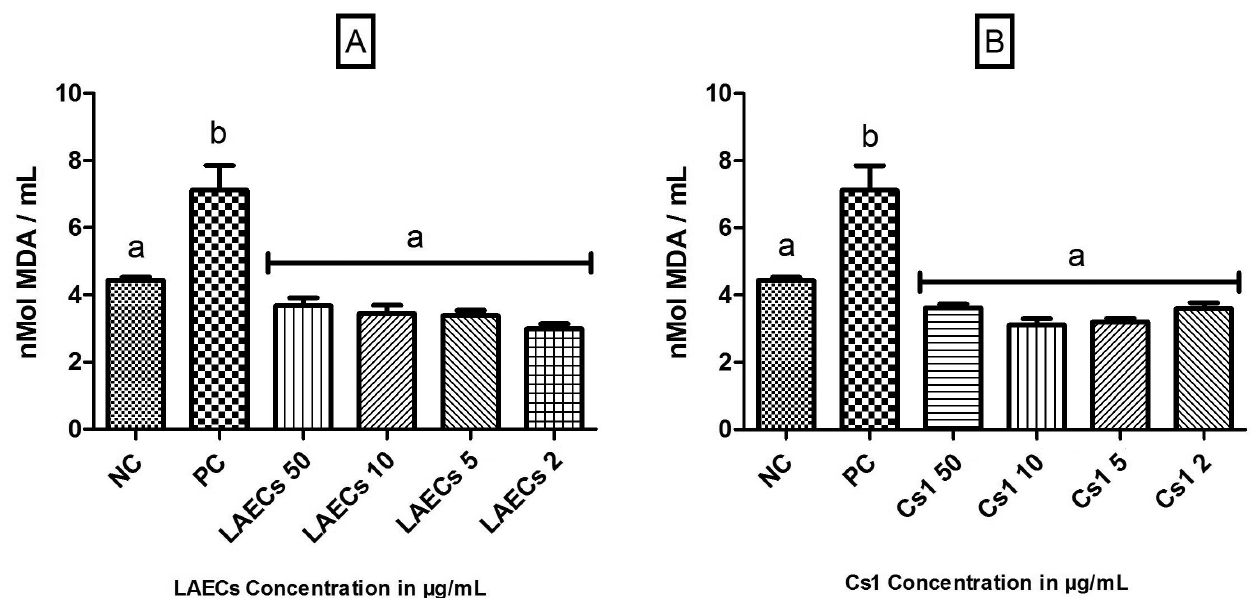
FIGURE 4 - Effects of lyophilized aqueous extract (LAECs) and raw ethanol extract (Cs1) on lipid peroxidation test induced by hydrogen peroxide (H O 100 µmol/L) in plasma. NC – Negative Control ( phosphate buffered saline ); PC – Positive Control; (H 2 2 100 µmol/L); (A) LAECs (50, 10, 5 and 2 µg/mL); (B) Cs1 (50, 10, 5 and 2 µg/mL). Data are expressed as mean ± SD. Columns with different letters are significantly different